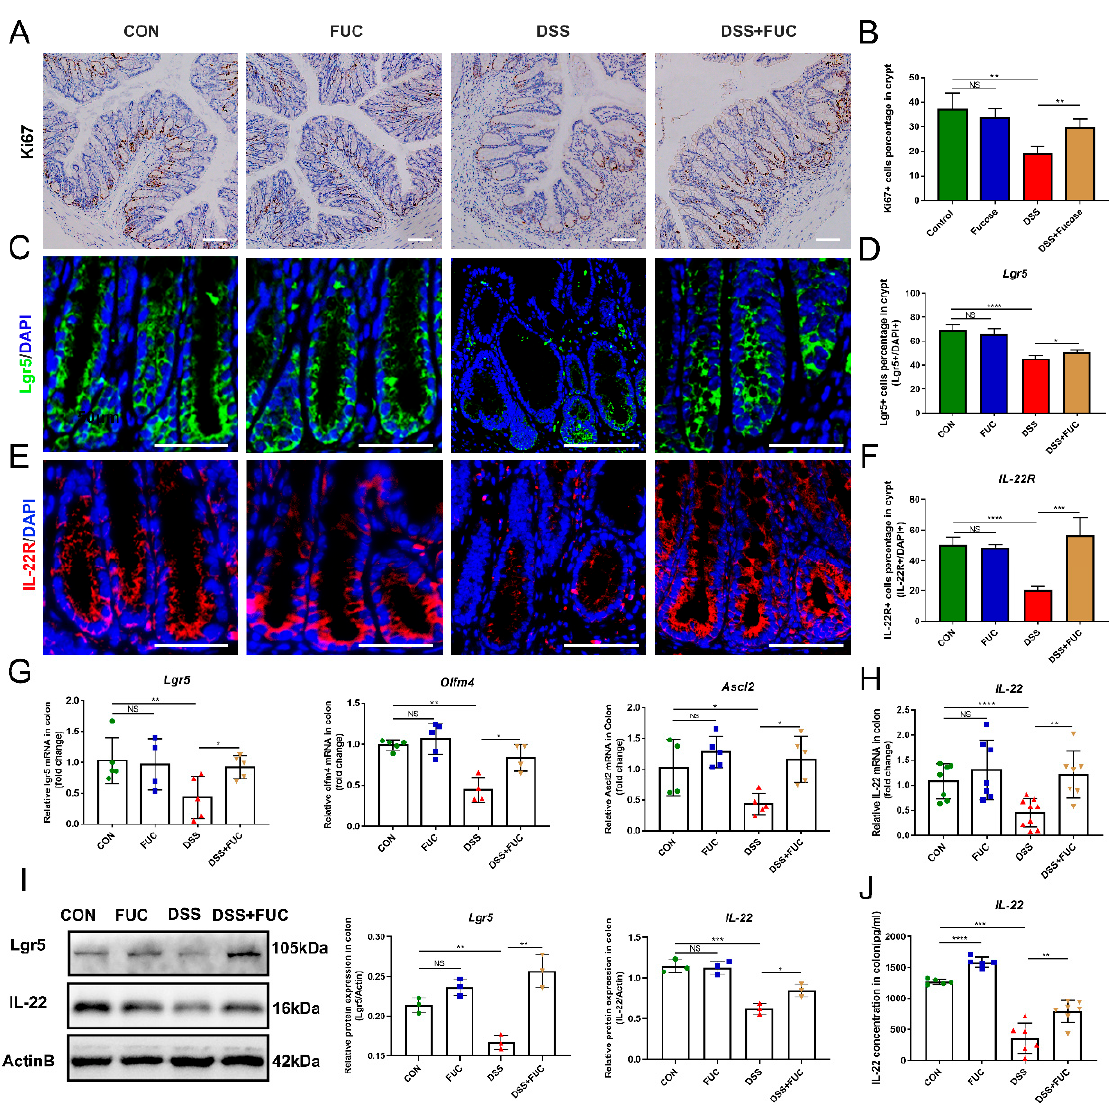
Figure 2. Increased ISC regeneration and IL-22 secretion in mice treated with L-fucose. ( A ) Rep- resentative images of Ki67 immunohistochemistry of the colon (scale bar, 100 µ m). ( B ) Ki67 + cell percentage in crypts. ( C ) Representative images of Lgr5 (green) in the colon (scale bar, 50 µ m). ( D ) Lgr5-positive cell percentage in crypts. ( E ) Representative images of IL-22R (red) in the colon (scale bar, 50 µ m). ( F ) IL-22R-positive cell percentage in crypts. Quantitative reverse-transcriptase polymerase chain reaction (qRT-PCR) analysis of ( G ) Lgr5, Olfm4, Ascl2 and ( H ) IL-22 in the colon. ( I ) Western blotting analysis of Lgr5 and IL-22 proteins in the colon. ( J ) ELISA analysis of IL-22 in the colon. The scale bar represents 100 µ m. Data are expressed as the mean ± SD. * p < 0.05, ** p < 0.01, *** p < 0.001, **** p < 0.0001; NS, no significance.